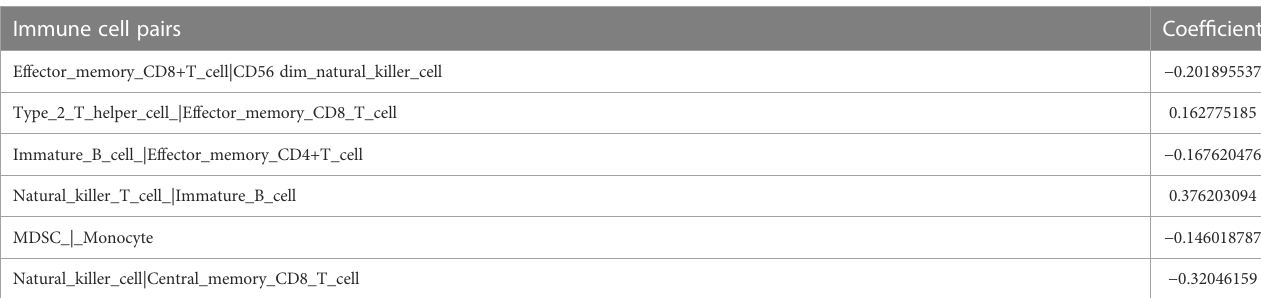
TABLE 1 The fi nal immune cell pairs and the corresponding coef fi cient generated by multi-Cox regression. Immune cell